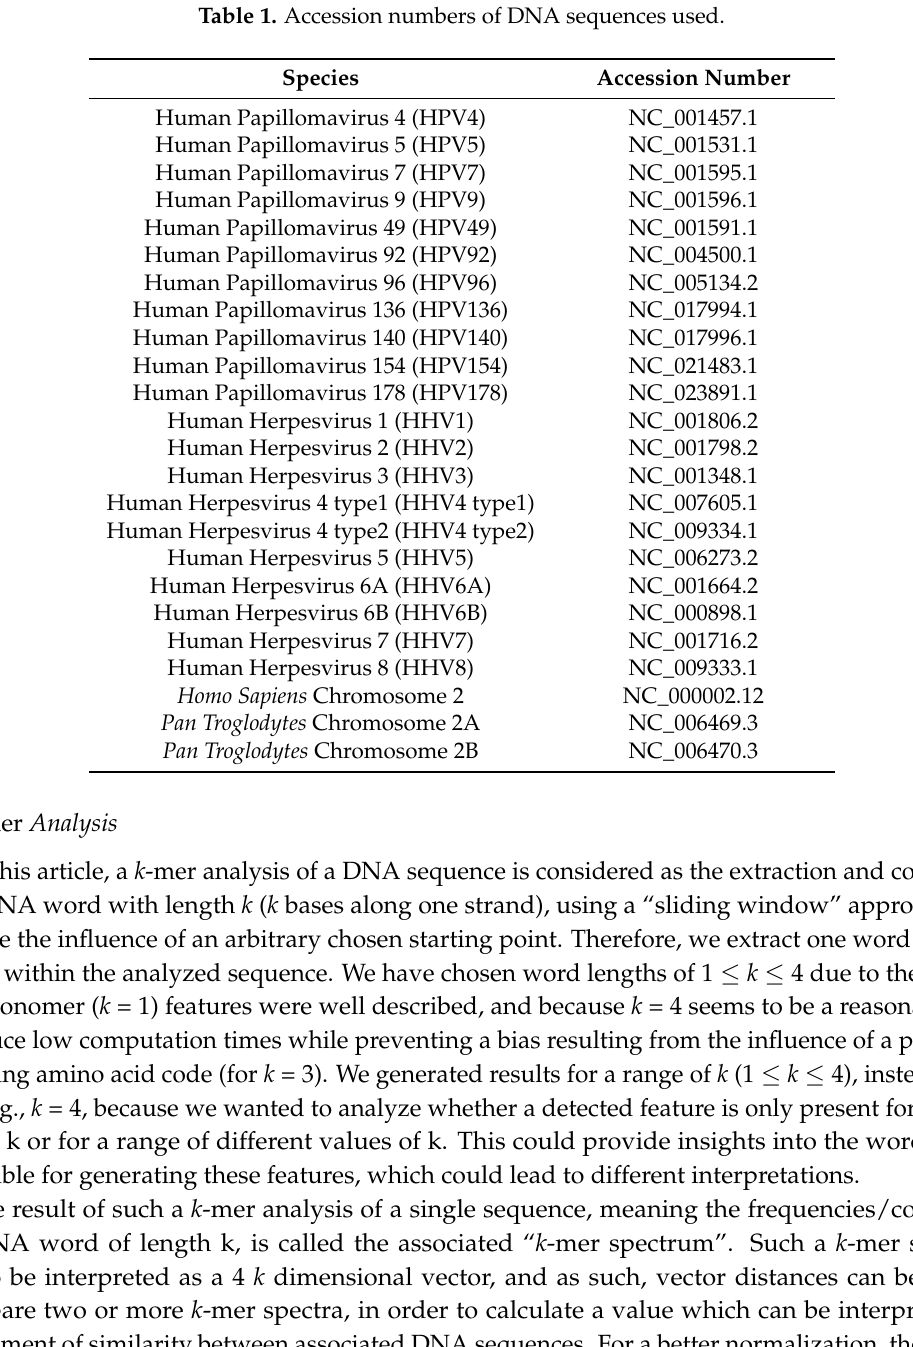
Table 1. Accession numbers of DNA sequences